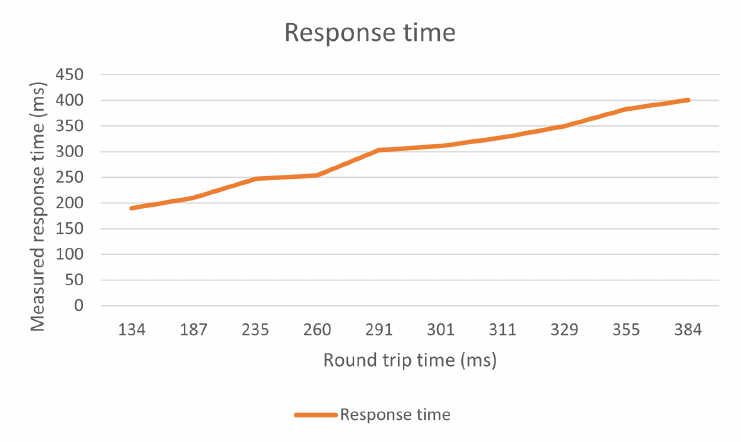
Figure 4. Response time from a cloud server to the edge device in relation to differing round trip